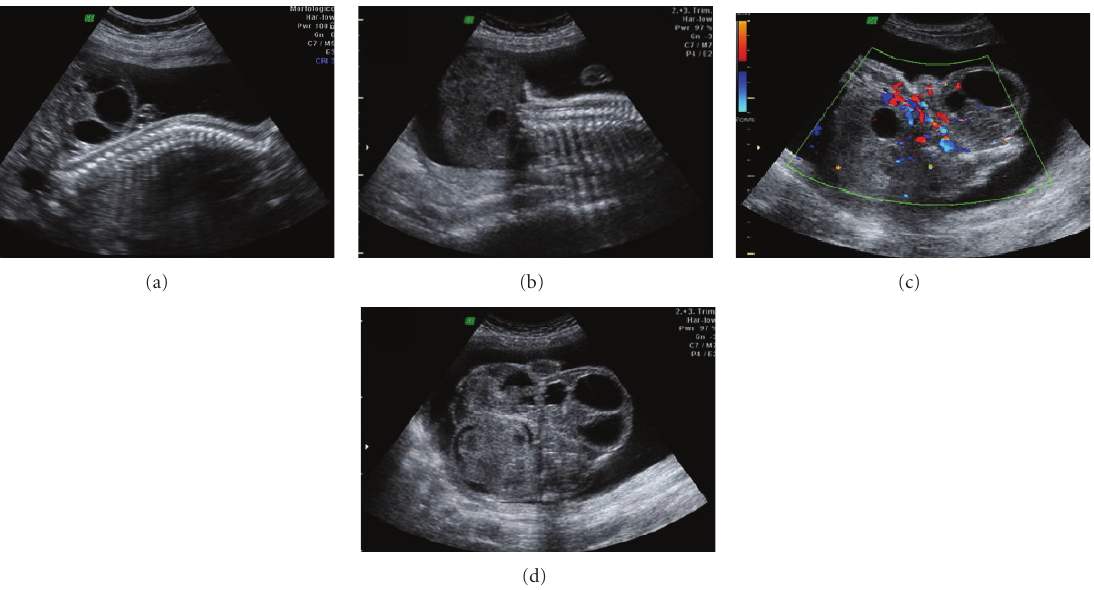
Figure 1: Two-dimensional ultrasound images of a sacrococcygeal teratoma. (a) and (b) Sagittal view of the fetal lumbosacral region, showing a large mass in which solid components predominated, in B mode. (c) Axial view of the fetal pelvis, showing the presence of large- scale flow inside the mass, on color Doppler. (d) Axial view of the fetal pelvis, showing large mass in which solid components predominated, in B